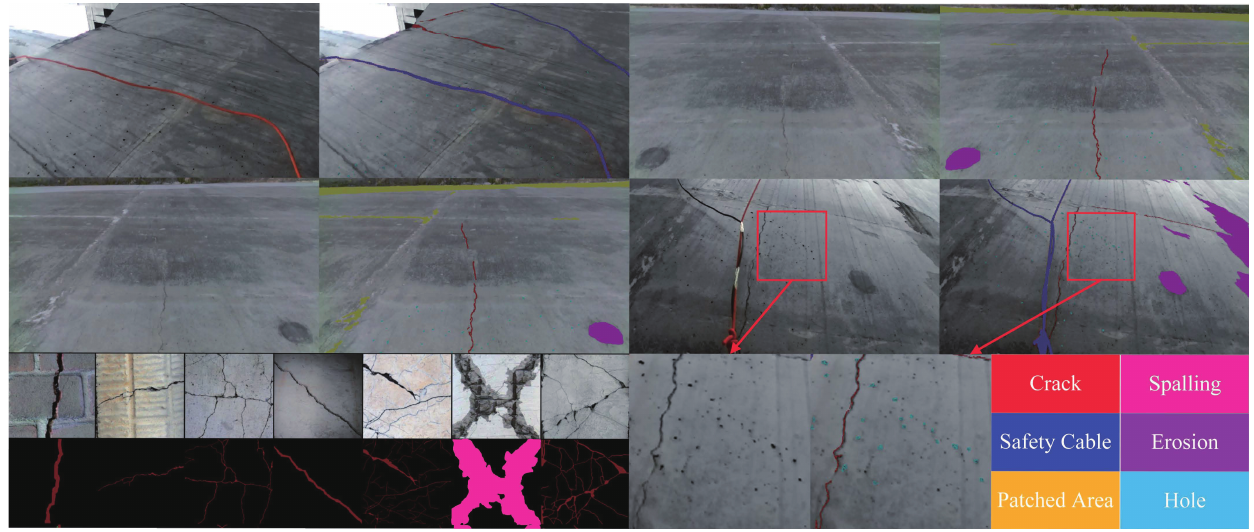
Figure 2. Sample images from DSI dataset combined with CSSC dataset. The first two rows are the dam surface multi-defect dataset we collected. Contains crack, patched area, erosion, spot, rope categories, and the two rows in the lower left corner are CSSC datasets, including crack and spalling defect